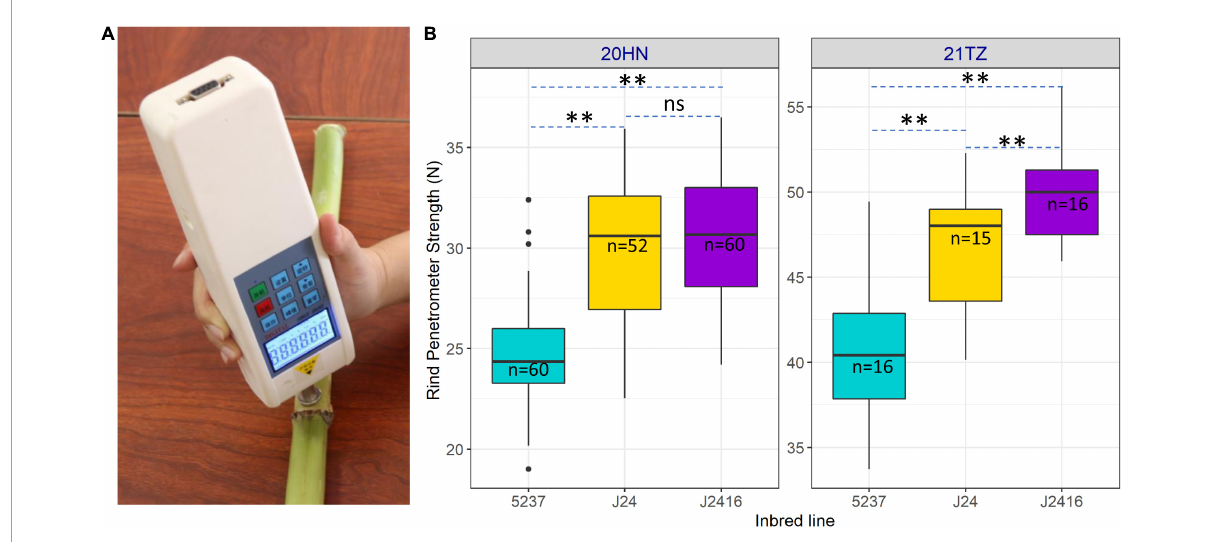
FIGURE2 Rind penetrometer strength of J2416 and its two parents. (A) Measurement of rind penetrometer strength. (B) Rind penetrometer strength of three inbred lines in different locations. ∗∗ Means the significant difference at 0.01 level. ns means no significant difference.